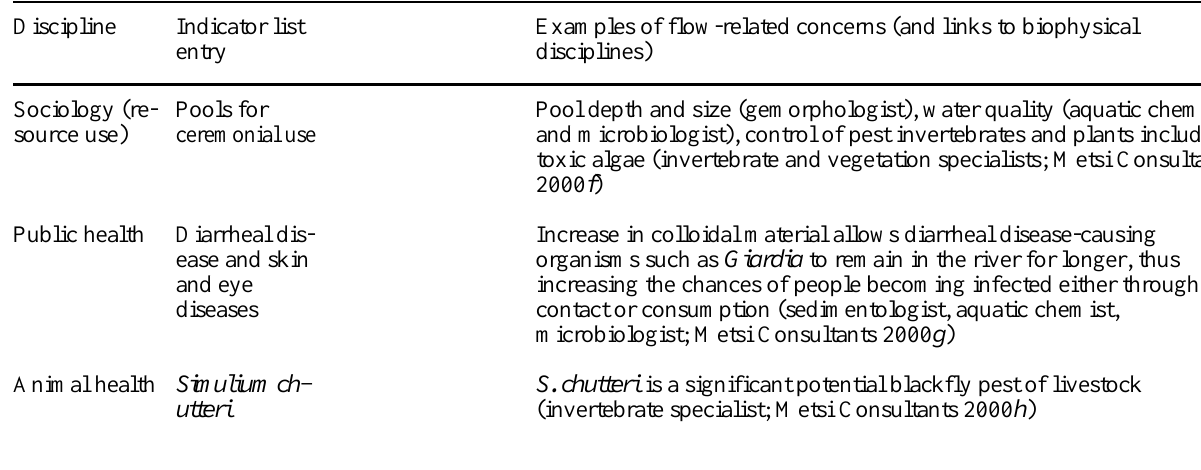
Table 7 . Examples of entries in the socioeconomic indicator lists for the Lesotho